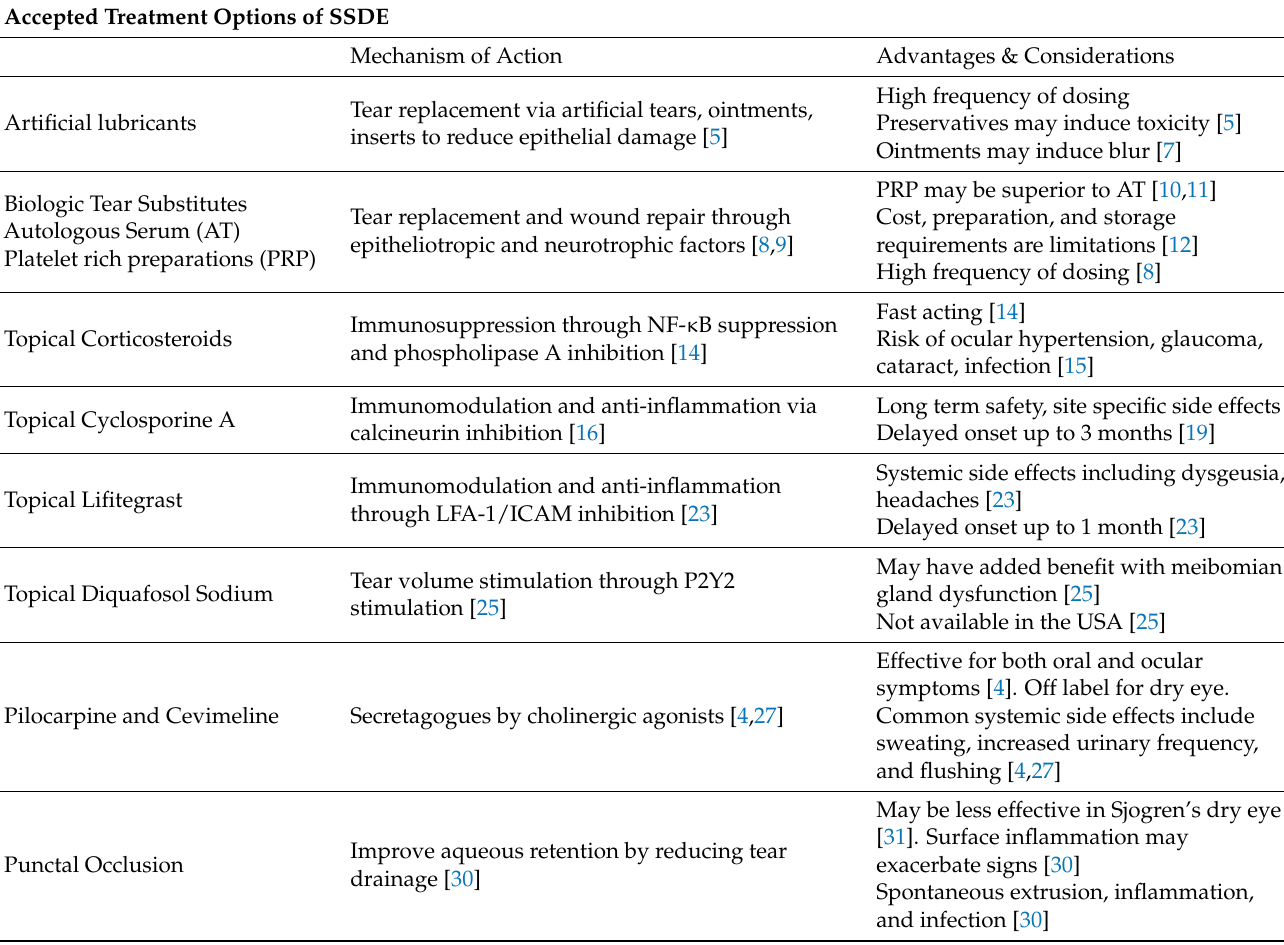
Table 1. Summary of conventional treatment options of